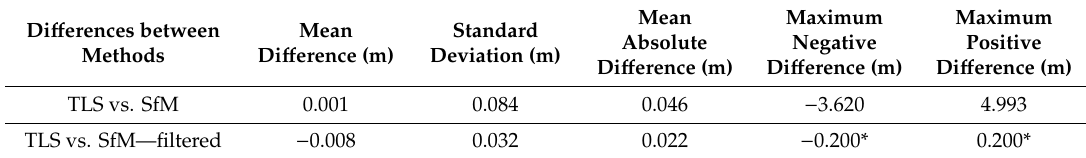
Table 5. Comparison of the point clouds—di ff erences in the z axis.